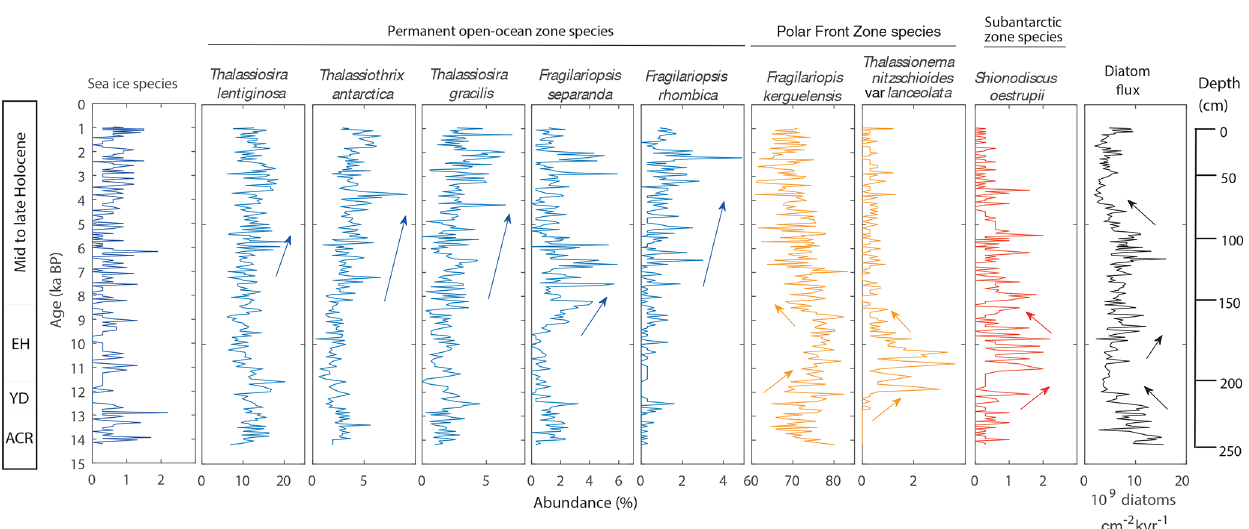
Figure 3. COR1GC diatom abundances as percentages of total sample and the total diatom flux. Note that the species are plotted on different x -axis